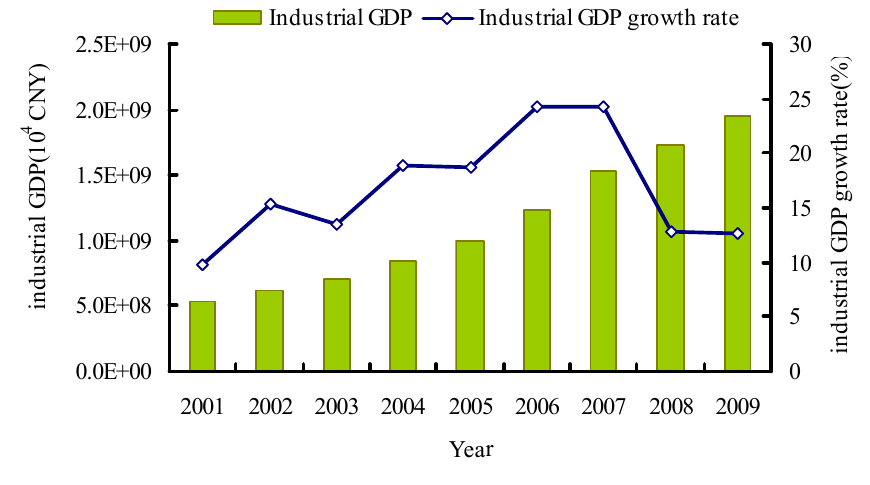
Figure1. Changes of China’s industrial gross domestic product during 2001–2009 (Data resources: Annual Statistic Report on Environment in China—ASREC